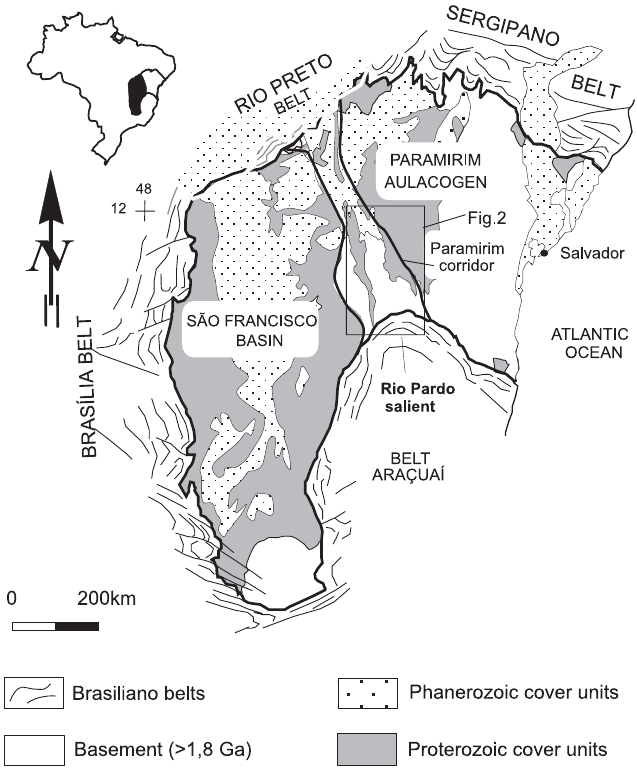
Fig. 1 – Simplified geologic map of the São Francisco craton showing the Paramirim aulacogen, the Paramirim corridor and the Araçuaí belt. The box indicates the location of Figure 2 (Based on Alkmim et al.